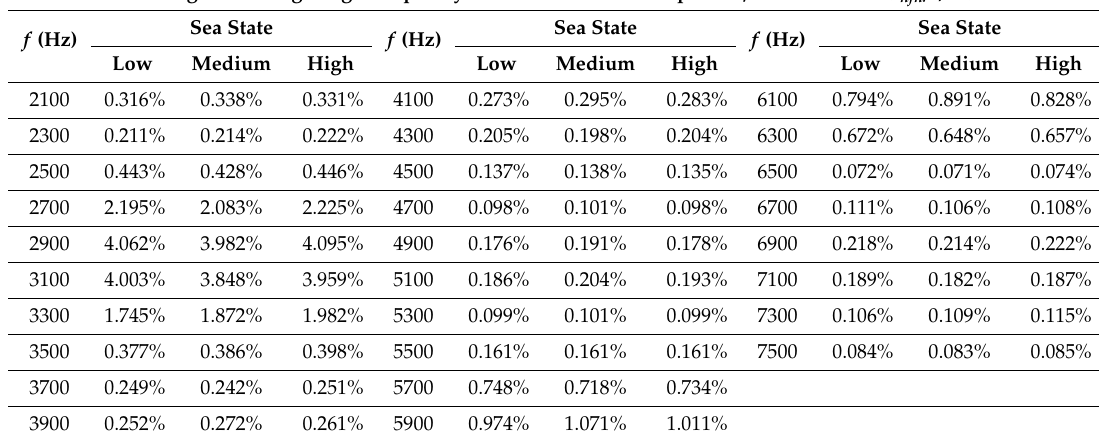
Table 6. Sea trial average reportable ratios of high-frequency harmonic current amplitudes for each resource